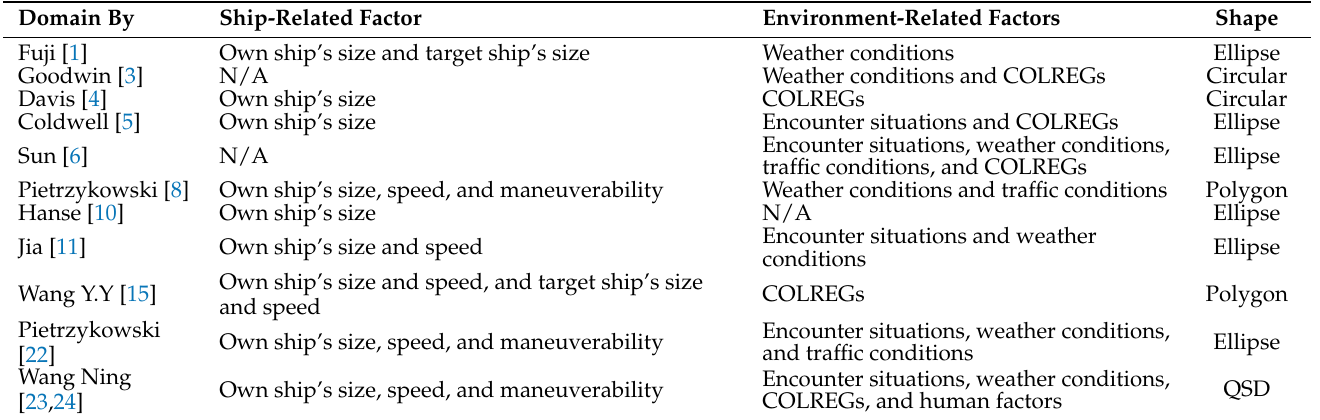
Table 1. The factor taken into account in the representative domain, and the shape of the